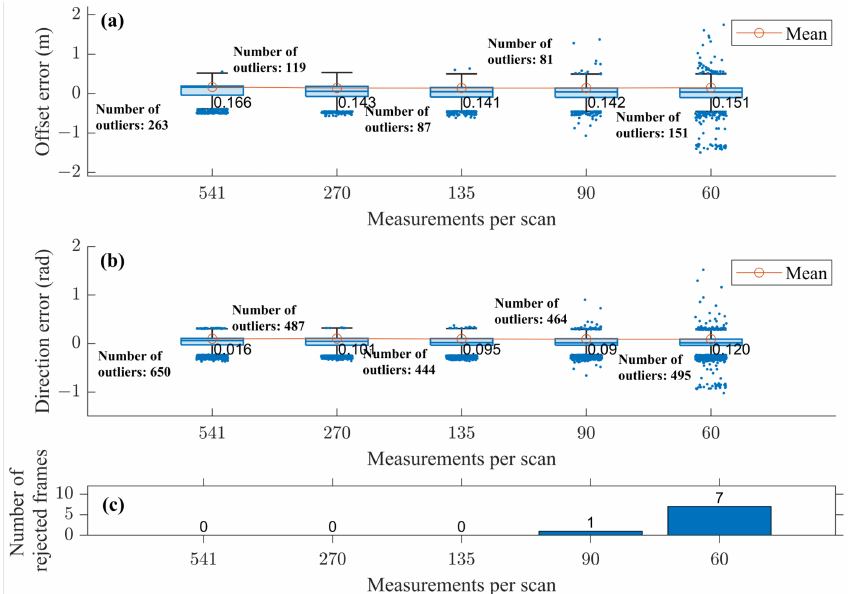
Figure 18. Result from dataset 2 with different data rates: ( a ) offset error; ( b ) direction error; ( c ) number of rejected